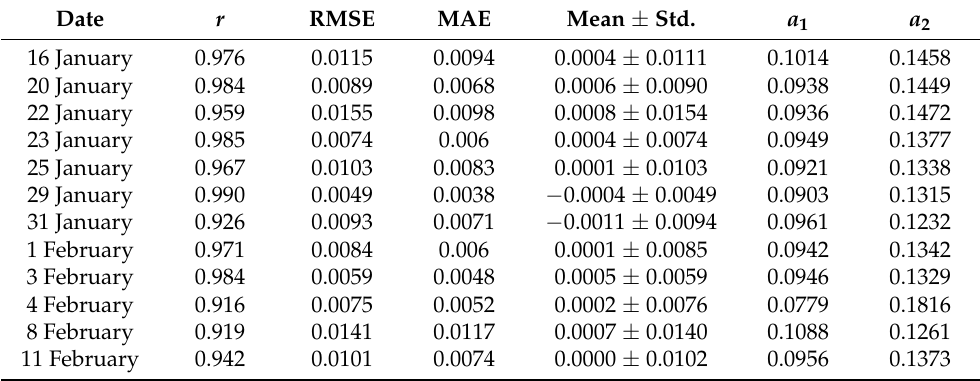
Figure 6. Simulation curves of the albedo derived from the Laplace combination for 12 sunny days with a solar altitude angle of ≥ 5 ◦ : ( a ) 16 January and 1 February, ( b ) 29 January and 4 February, ( c ) 20 January and 3 February, ( d ) 22 January and 8 February, ( e ) 23 January and 31 January, ( f ) 25 January and 1 February The circles and lines are measured data and fitted curves, respectively. Table 6. Correlation coefficients, errors (simulated minus measured albedo), and overall simulation coefficients a 1 and a 2 derived for the Laplace